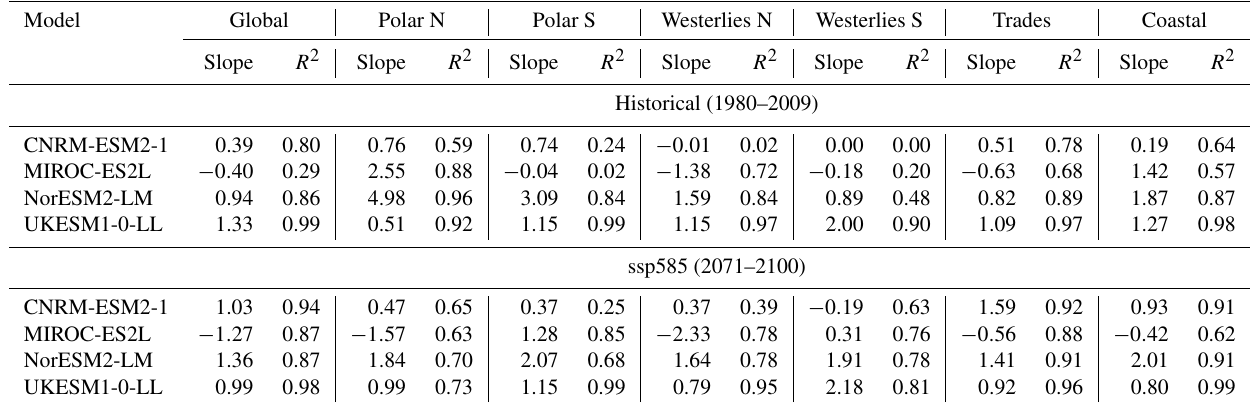
Table 8. Metrics of the scatter plots of Fig. 13; change in DMS concentration vs. change in NPP: slopes of the linear regressions (10 − 2 nM per (gCyr − 1 )) and determination coefficients. Metrics are shown for the four models, over two periods (1980–2009 and 2071–2100) in global mean and for the six biomes, as in Fig.